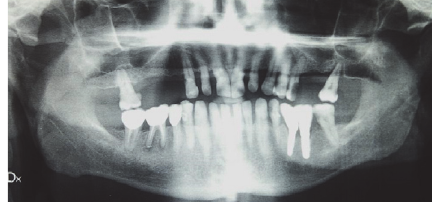
Figure 2: Starting case, full-mouth intraoral radiographic exam.